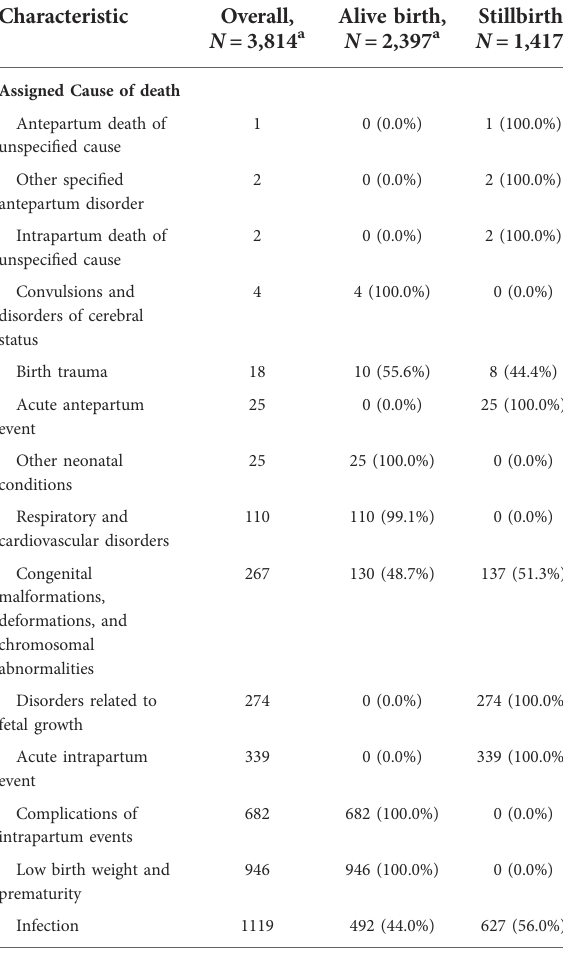
TABLE 4 Selected characteristics of the perinate by outcome status in Ethiopia, 2021.